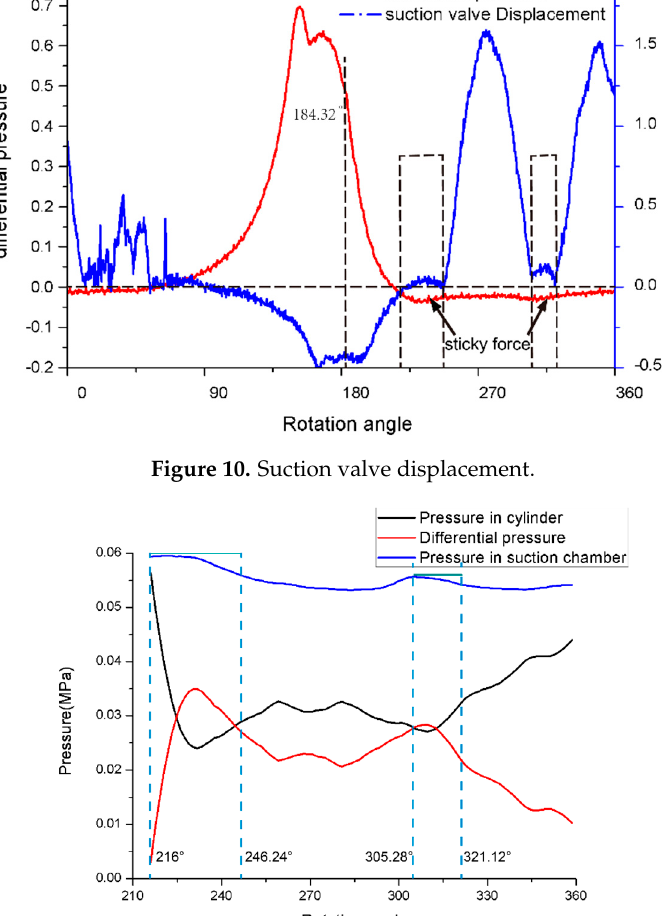
Figure 11. Pressure pulsations during suction valve motion.